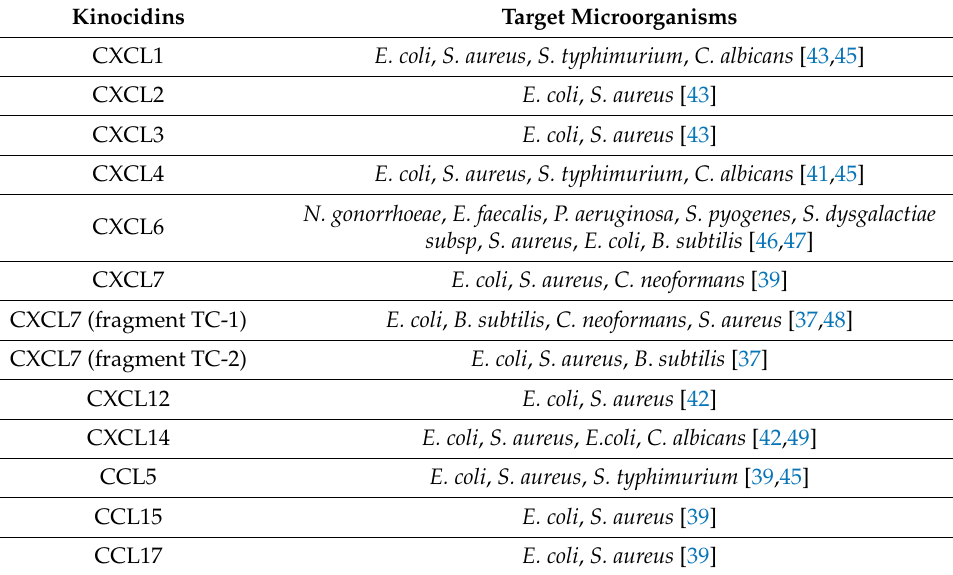
Table 1. Key kinocidins in human platelets and target microorganisms. Adapted from Aquino- Dom í nguez et al.